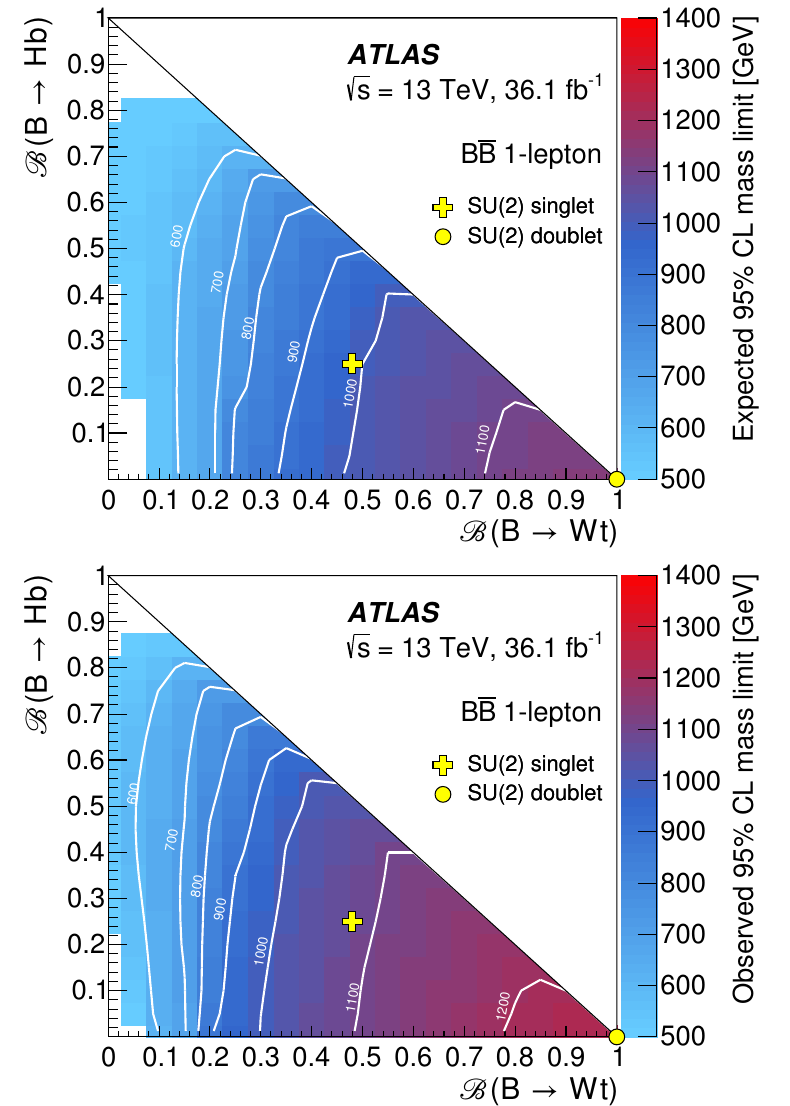
Figure 6 . Expected (top) and observed (bottom) 95% CL lower limits on the mass of the B quark as a function of the decay branching ratios into B ( B ! Wt ) and B ( B ! Hb ). Contour lines are provided to guide the eye. The markers indicate the branching ratios for the SU(2) singlet and doublet scenarios with masses above (cid:24) 0.8 TeV, where they are approximately independent of the VLQ B mass. The white regions are due to the limit falling below 500 GeV, the lowest simulated signal